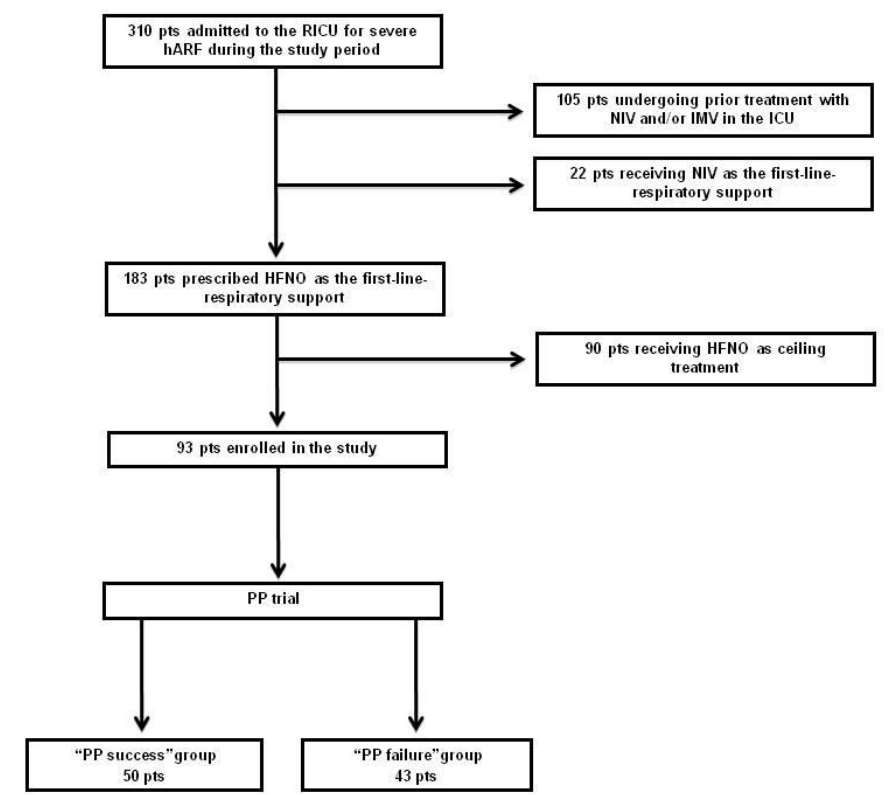
Figure 1. Study profile (hARF = hypoxemic Acute Respiratory Failure; HFNO= High Flow Nasal Oxygen; IMV= Invasive Mechanical Ventilation; NIV= Noninvasive Ventilation; PP = Prone Positioning; RICU = Respiratory Intermediate Care Unit).